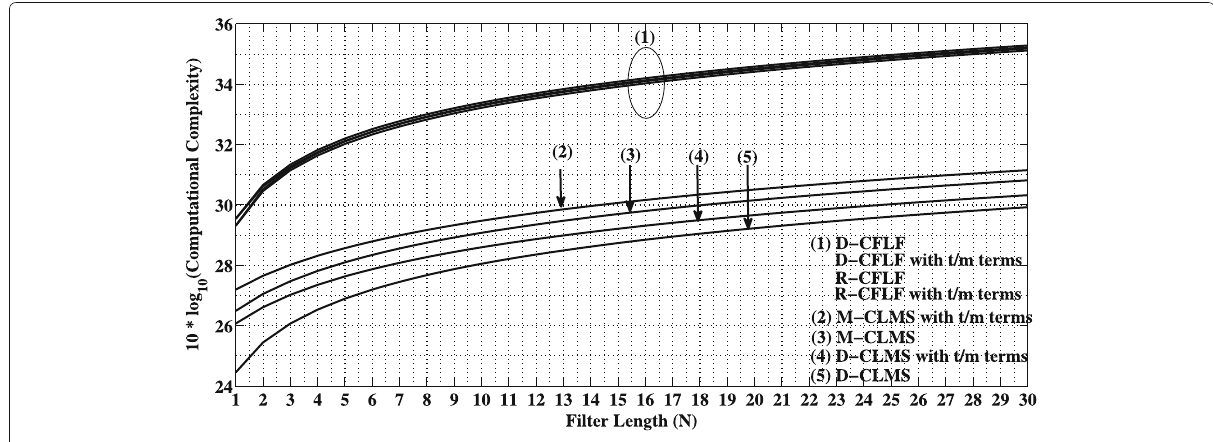
Fig. 7 Computational complexity comparison for M = 4